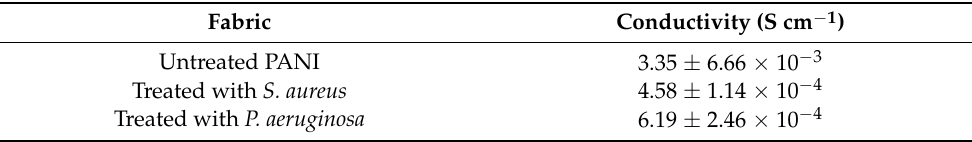
Table 5. Conductivity values of untreated PANI fabric, and PANI fabric treated with S. aureus and P. aeruginosa.